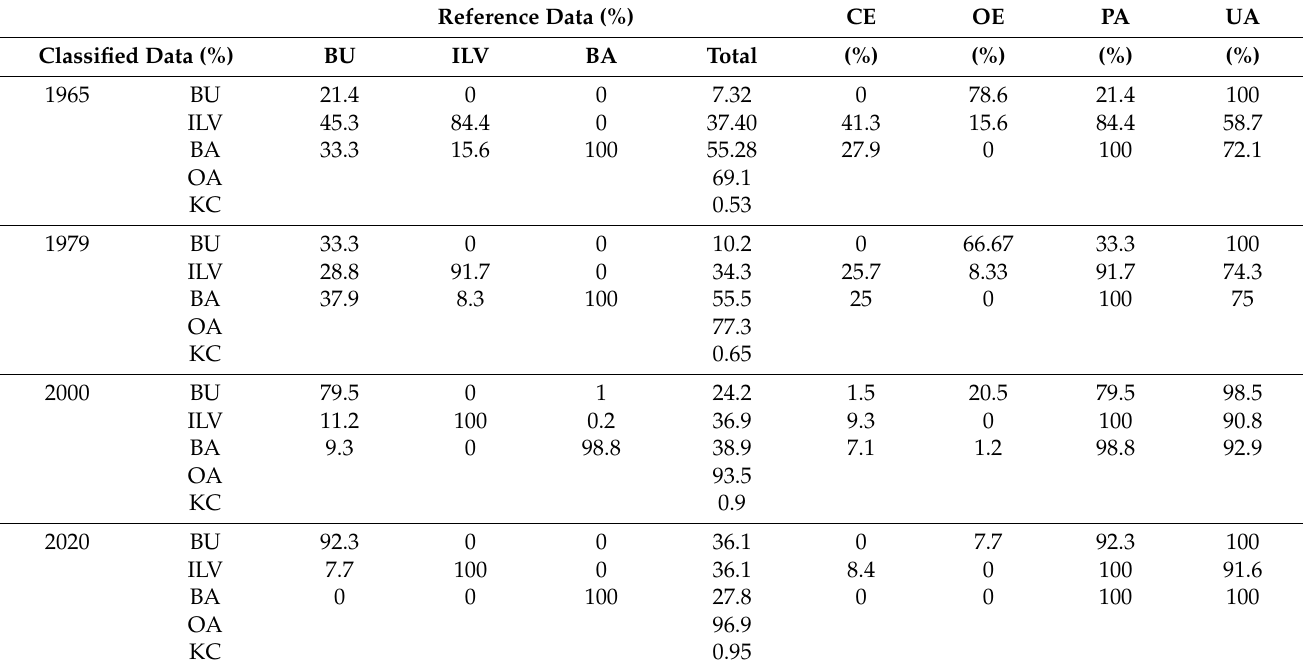
Table 3. Accuracy assessment of land use and land cover (LULC) detection of Kargil town in